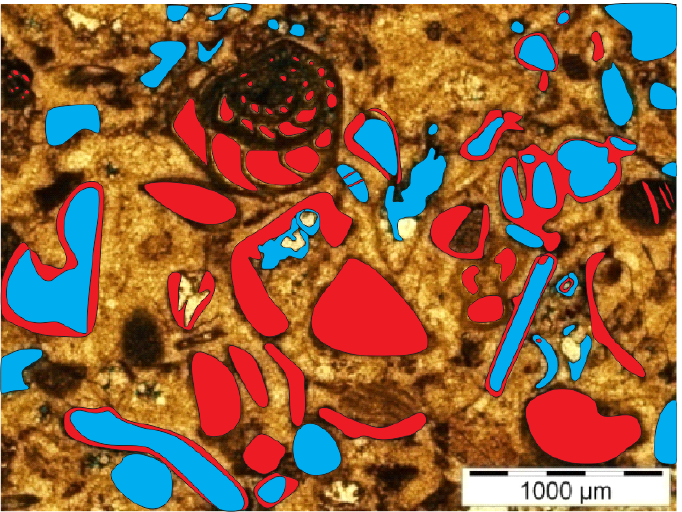
Figure 7. False color DIA image of mouldic, vuggy and intraparticle porosity developed in foraminifera and different bioclasts in Well A. Total porosity is 19%, the blue color represents macropores which are 8.5%, whereas red color represents microporosity which is 10.5%.